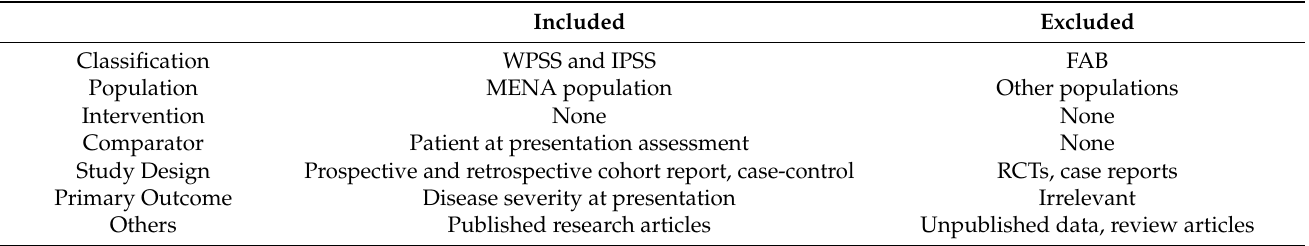
Table 1. Inclusion and exclusion criteria according to the PICOS statement.